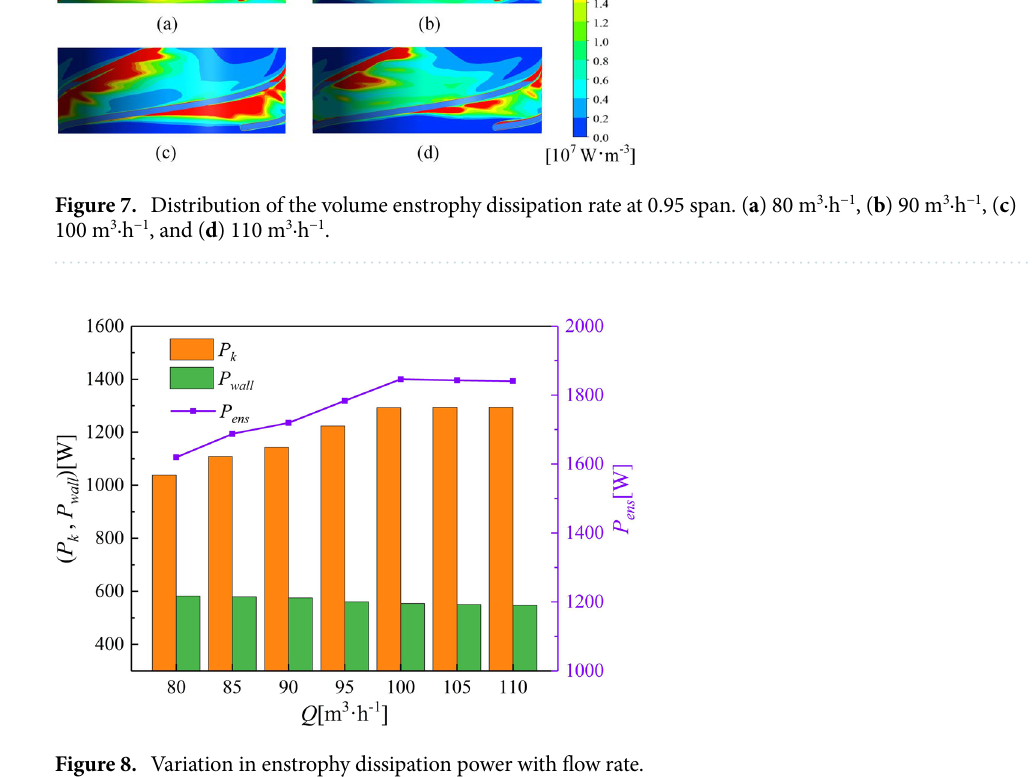
Figure 8. Variation in enstrophy dissipation power with flow